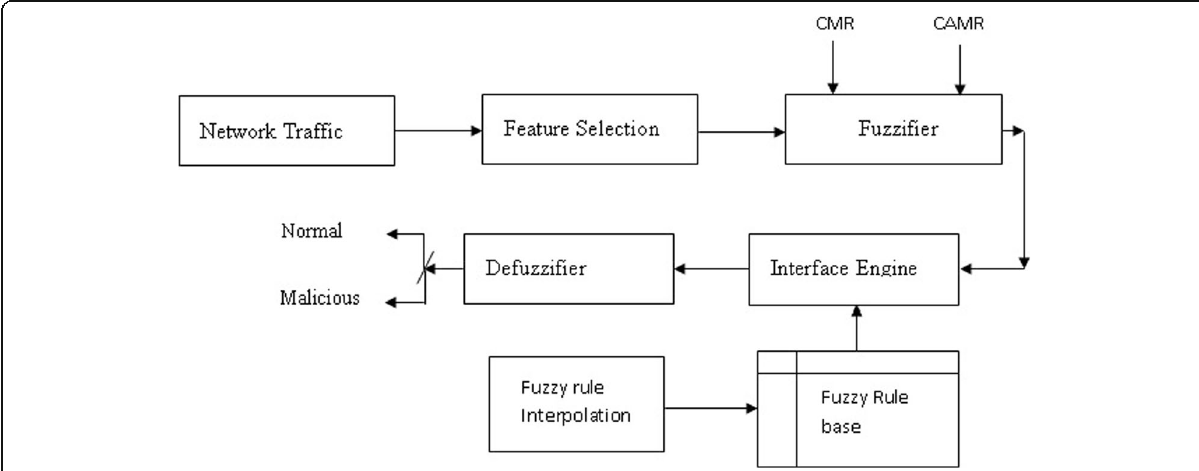
Fig. 4 Fuzzy based DoS detection in proposed